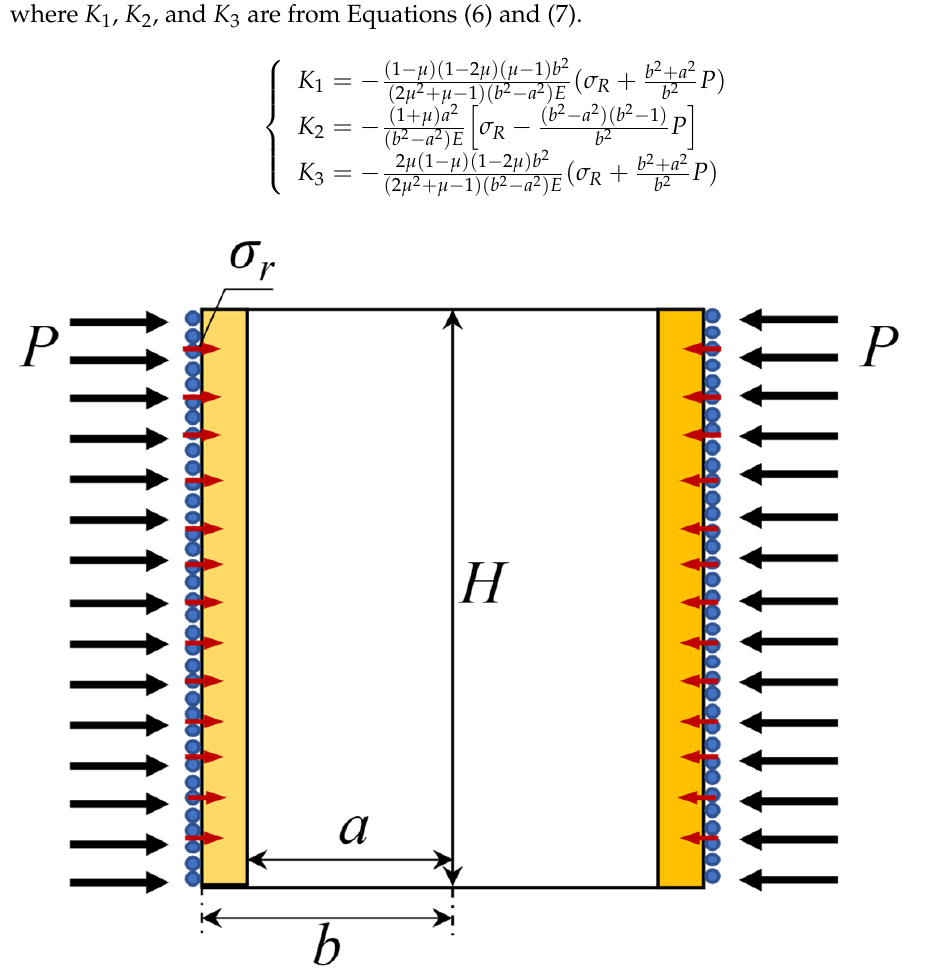
Figure 4. Pick-up boundary condition analysis diagram.